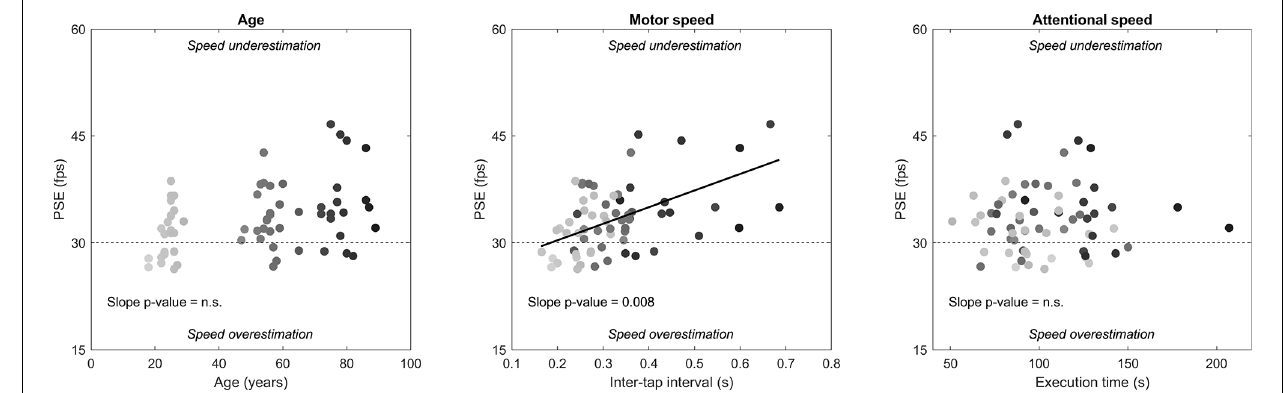
FIGURE 5 | Effects of participants’ age, motor speed (tapping task), and attentional speed (visual search task) on PSE (SoS task), as assessed through multiple regression. Each data-point represents an individual participant, where the greytone represents the participant’s age (darker = older). PSE tended to increase with age, but the effect was carried by motor speed, which was the only significant predictor of PSE (continuous line). Note that the values for motor and attentional speed represent in fact motor and attentional slowness. The horizontal dashed lines indicate the original video clip